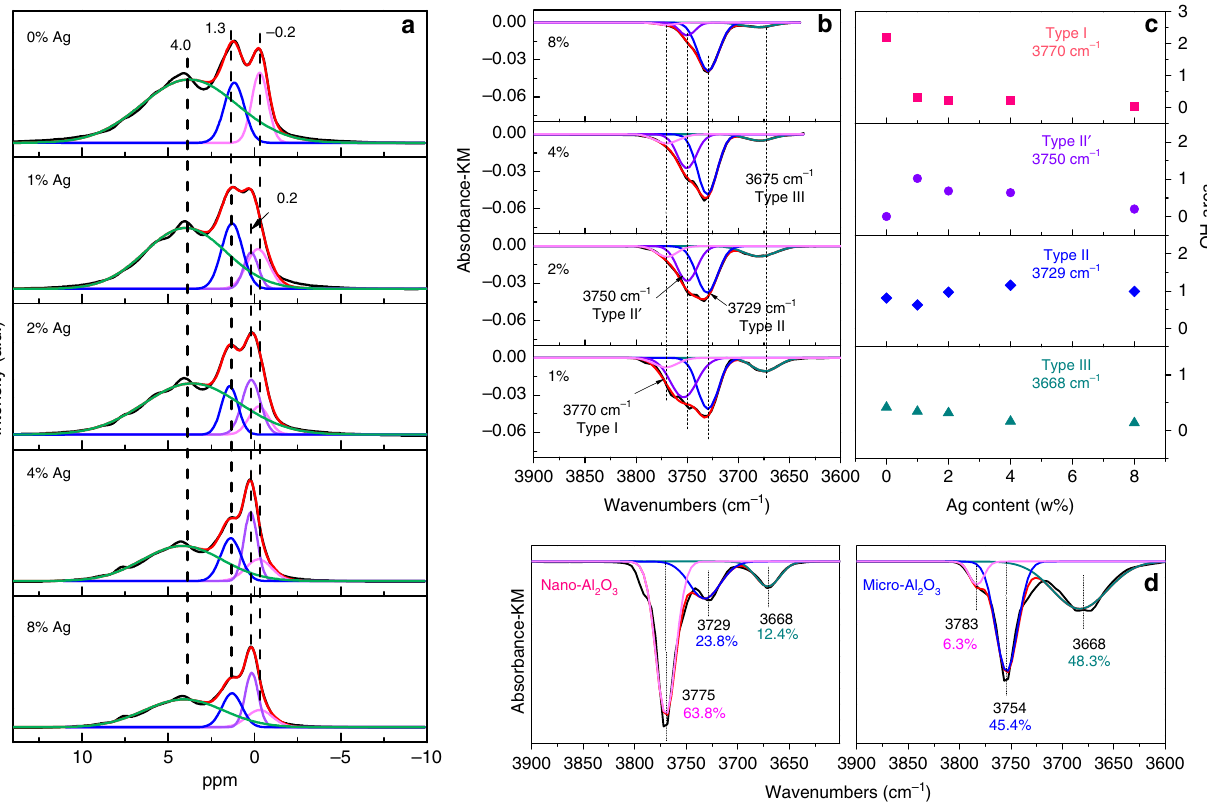
Fig. 4 1 H NMR and in situ DRIFTS spectra of Ag/ γ -Al 2 O 3 . a Normalized 1 H MAS NMR of Ag/nano-Al 2 O 3 with different silver loadings (0, 1, 2, 4, 8%) (Samples were dehydrated at 473 K for 12 h before NMR measurements), b peak resolving of OH consumption peaks after in situ DRIFTS of NH